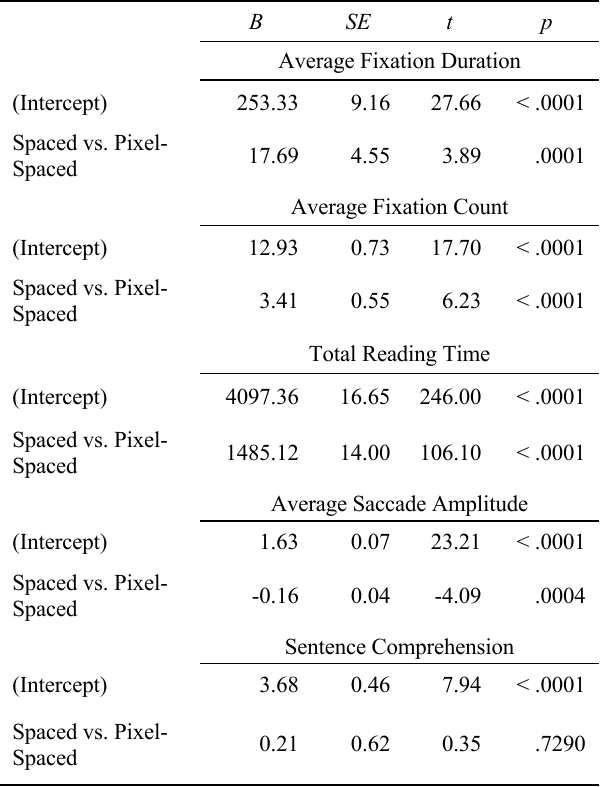
Table 2. Linear Mixed Models Outputs for the Measures Re- ported in Experiment